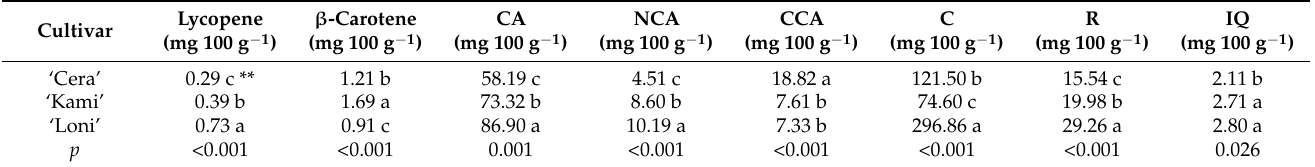
Table 7. Cultivar effects on honeyberry lycopene, β -carotene, chlorogenic acid (CA), neochlorogenic acid (NCA), cryptochlorogenic acid (CCA), catechin (C), rutin (R), and isoquercetin (IQ) contents